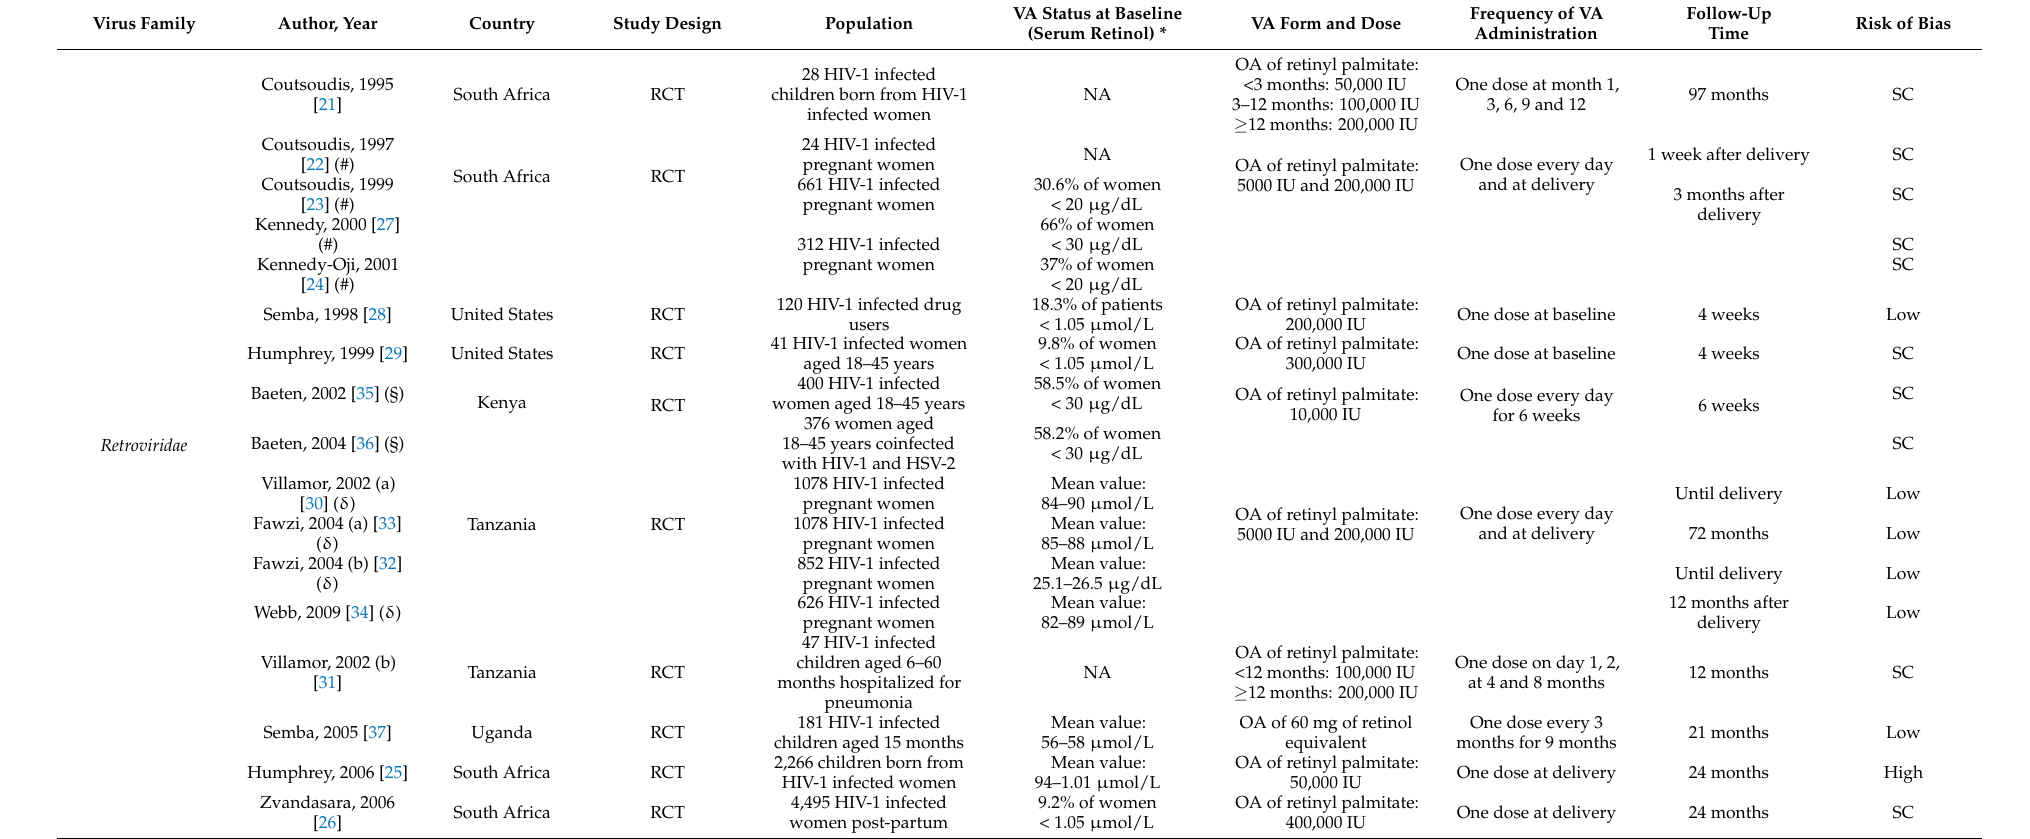
Table 1. Characteristics of the studies included in the systematic review by virus